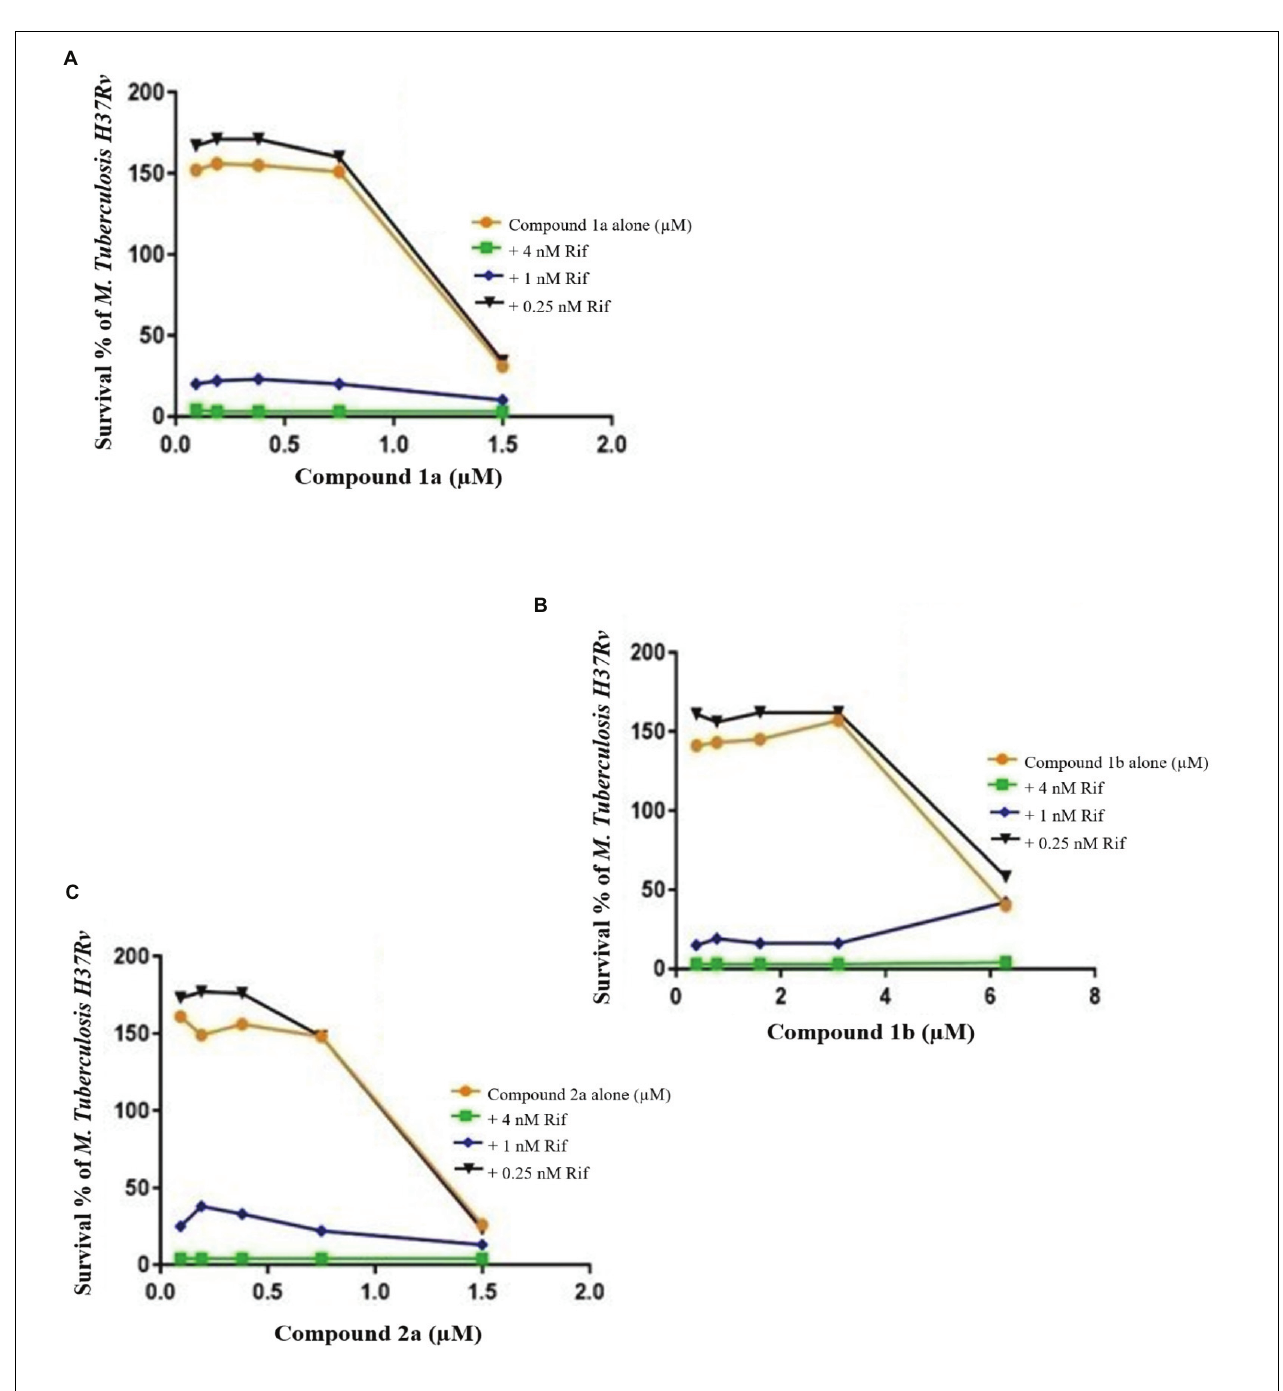
FIGURE 5 | Checkerboard study between rifampicin and 1a (A) , 1a (B) , and 2a (C) . TB. H37Rv was incubated with varying concentrations of rifampicin (Rif) together with dilutions of the synthetic drugs 1a (A) , 2a (B) , and 1b (C) . Graph displays the mean survival of triplicate samples and represents data from three independent